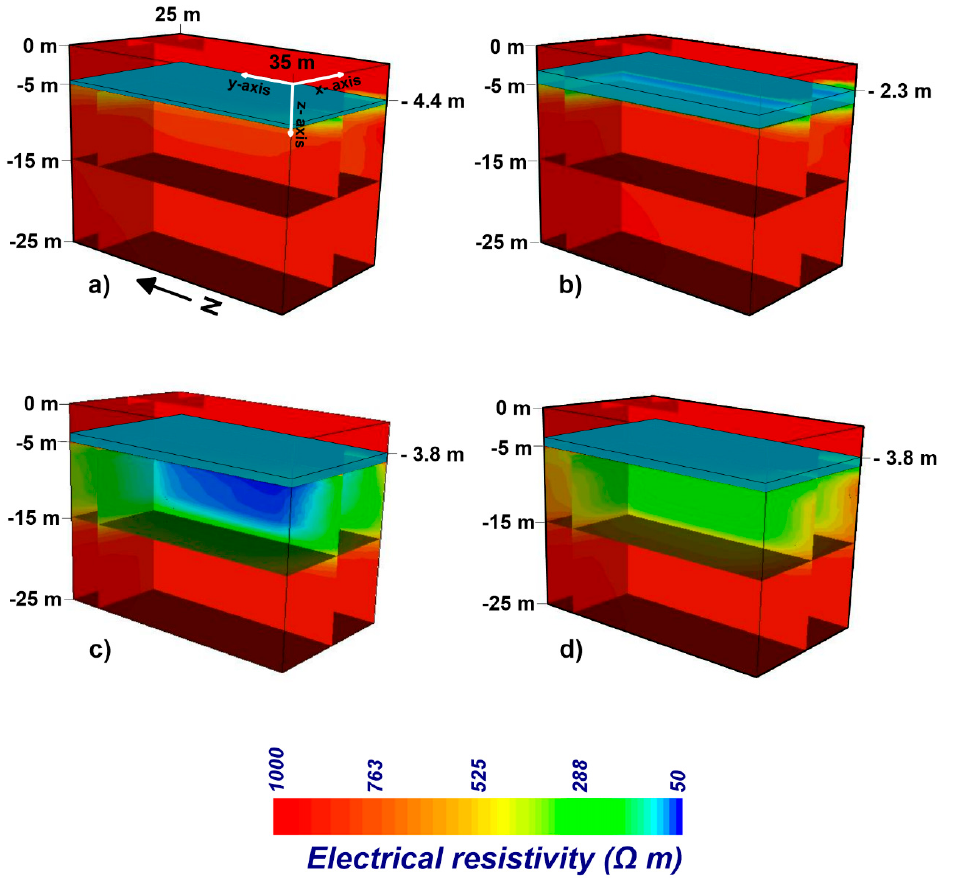
Figure 5. Forward-modeling outputs for Trench 9, considering four different configurations. ( a , b ) 0.60-m and 2.70-m hydraulic heads, respectively; ( c , d ) 1.20-m hydraulic head and 10-m-thick layer (from − 5 m to − 15 m bgs) set to 100 and 300 Ω m, respectively. The subsurface resistivity was always 1000 Ω m.